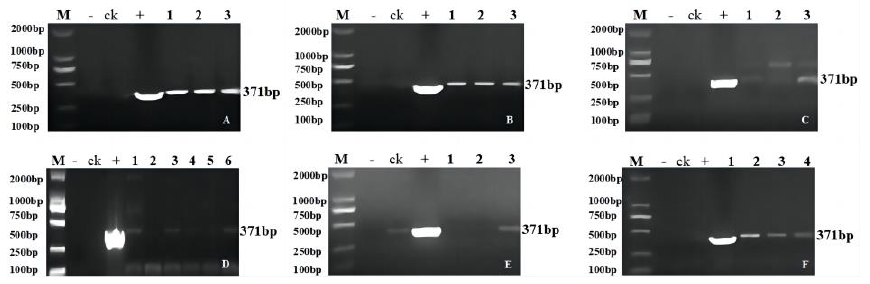
Figure 3. PCR detection of Bar gene in some T 1 generation transgenic plants: ( A ) 1–3 transgenic positive plants; ( B ) 1–3 transgenic positive plants; ( C ) 1–3 transgenic positive plants; ( D ) 1–7 transgenic positive plants; ( E ) 1–4 transgenic positive plants; ( F ) 1–3 transgenic positive plants. M: DL2000 DNA marker; +: positive plasmid; -: negative control.